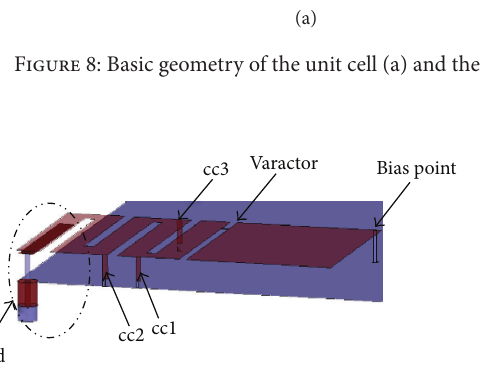
Figure 9: Reconfigurable meander antenna loaded with PIN diodes (cc1, cc2, and cc3) [18].